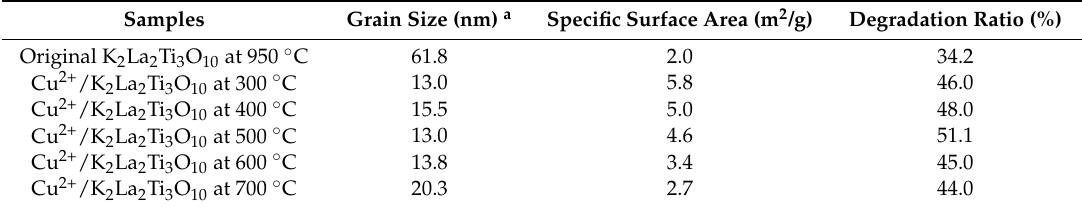
Figure 3. XRD patterns of and Cu 2+ /K 2 La 2 Ti 3 O 10 calcined at 300 °C ( a ), 400 °C ( b ), 500 °C ( c ), 600 °C ( d ), 700 °C ( e ); and original K 2 La 2 Ti 3 O 10 calcined at 650 °C ( f ), 750 °C ( g ), 850 °C ( h ), 950 °C ( i ).